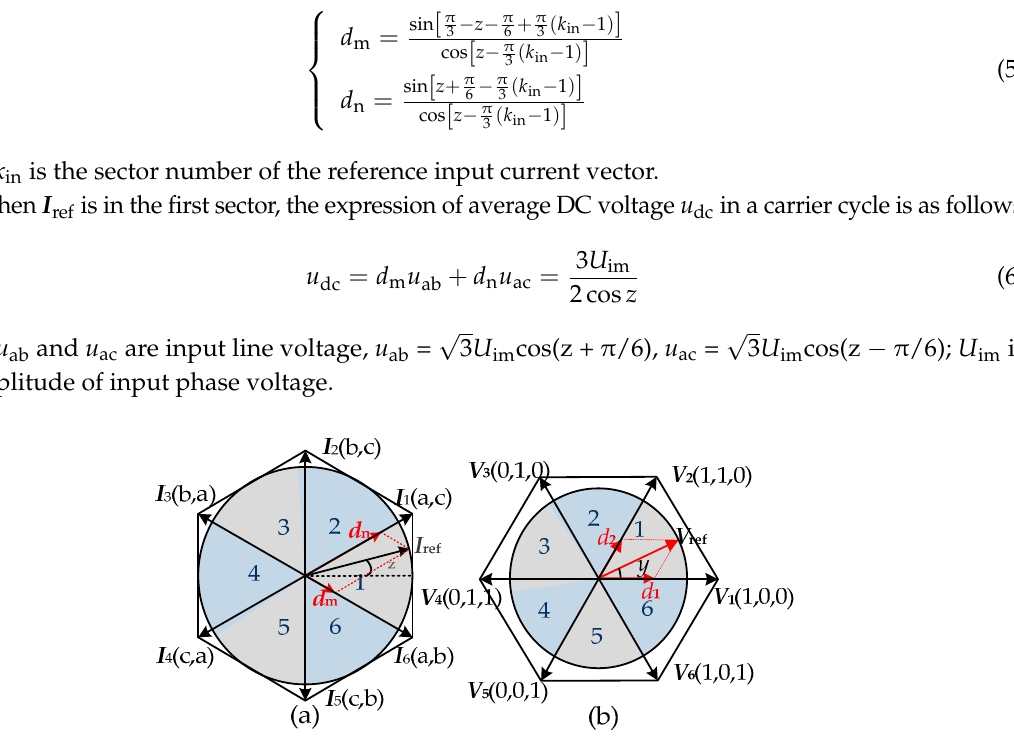
Figure 2. The space vector modulation strategy of Ultra Sparse matrix converter ( a ) rectifier stage ( b ) inverter stage.